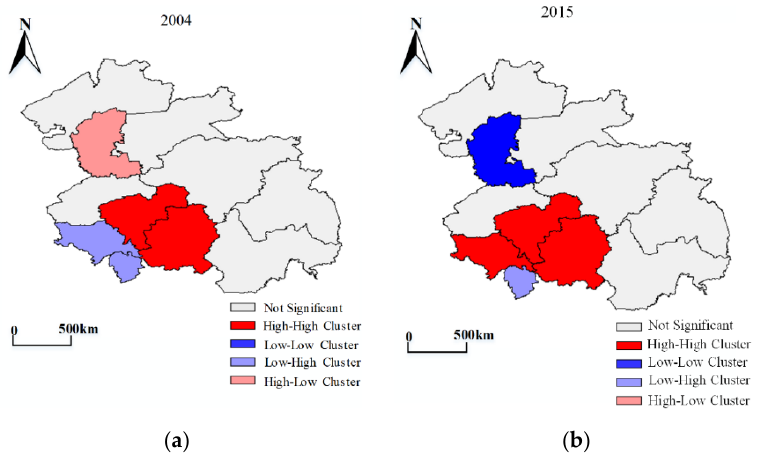
Figure 8. Spatial distribution of the LCCC in the HCUA. ( a , b ) are spatial distribution maps of LCCC in 2004 and